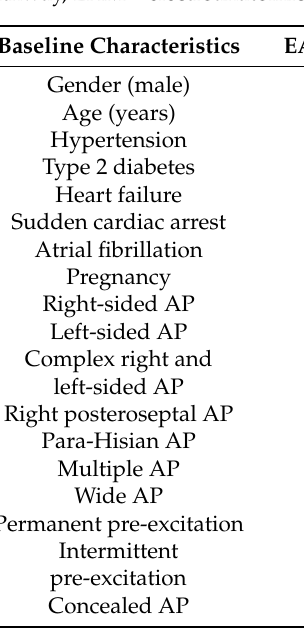
Table 1. Characteristics of patients (the values are means ± standard deviation). AP—accessory pathway, EAM—electroanatomic